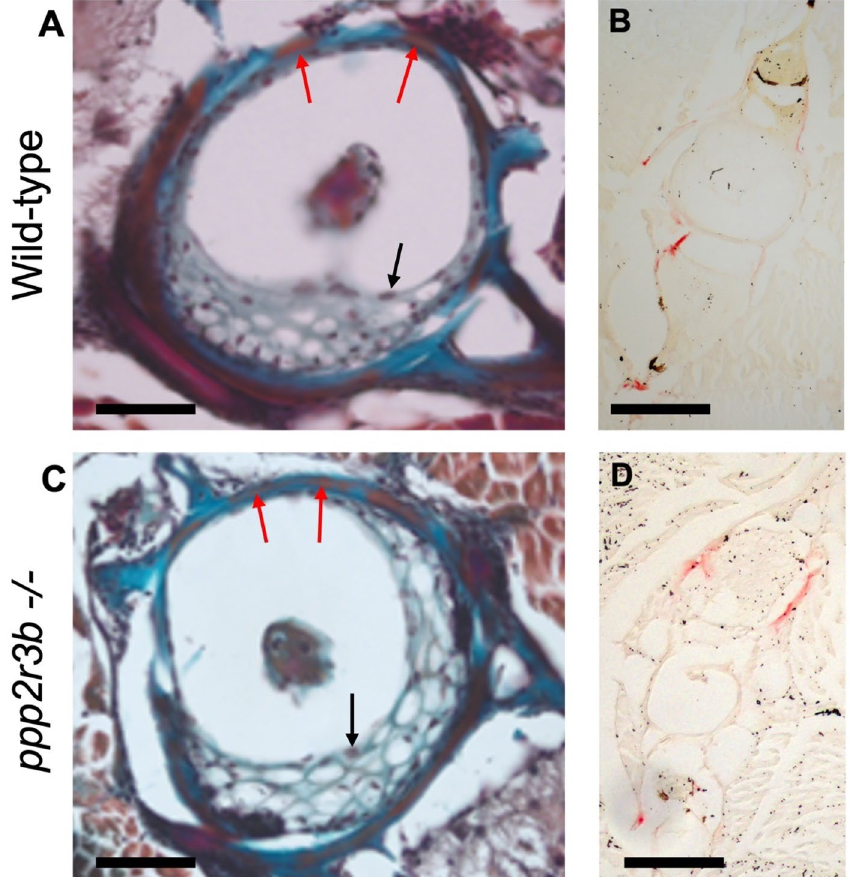
Figure 10. No obvious changes in osteoclast or osteoblast staining in vertebrae. ( A , C ) Mallory’s trichrome staining of vertebra centra. Black arrows show examples of vacuolated chordoblasts (osteoblasts) within the vertebra centrum while red arrows show squamous chordoblasts within the notochord sheath. ( B , D ) tartrate- resistant acid phosphatase (TRAP) staining in transverse sections from wild-type and ppp2r3b−/− mutant zebrafish at 36 dpf. Red signal indicates TRAP staining in neural and haemal arches, but no staining was detected within the vertebrae centra. Scale bars are 50 µm in ( A , C ); 14 µm in ( B , D